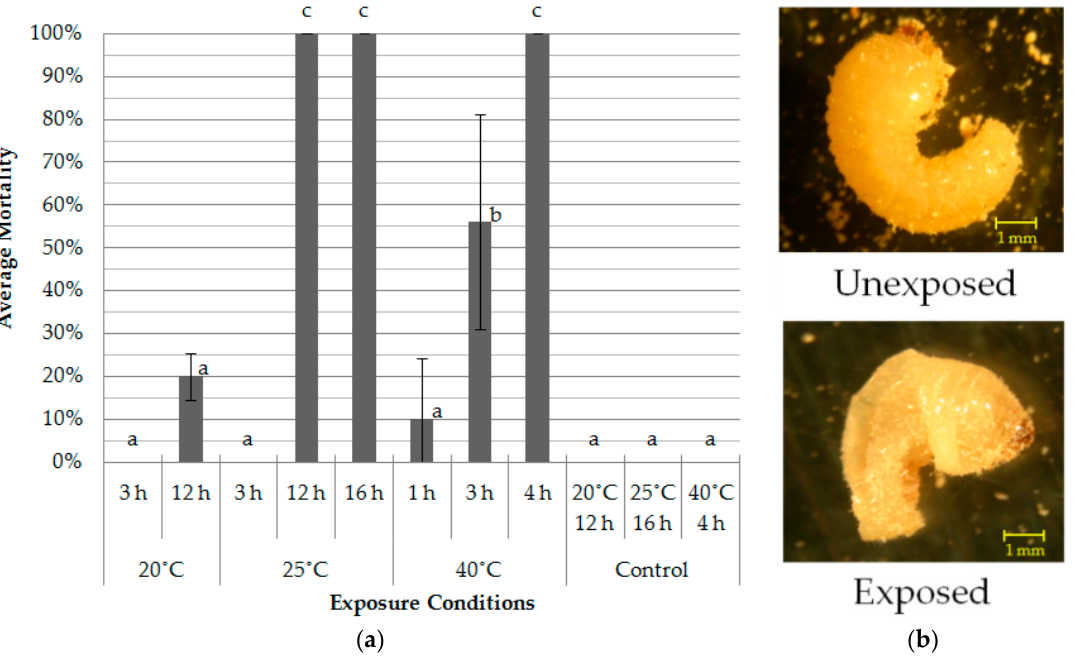
Figure 4. Mortality and the change of shape of L. africanus larvae by the high vacuum treatment ( n = 5). ( a ) Mortality (mean ± SD) after decompression treatment at 1.1 kPa, ( b ) Photographs of larvae of L. africanus before (upper) and after treatment (bottom) at 25 °C, 1.1 kPa for 12 hours. For each condition, means with the same letters are not significantly different (Tukey-Kramer test; p < 0.05) following one-way analysis of variance (ANOVA).